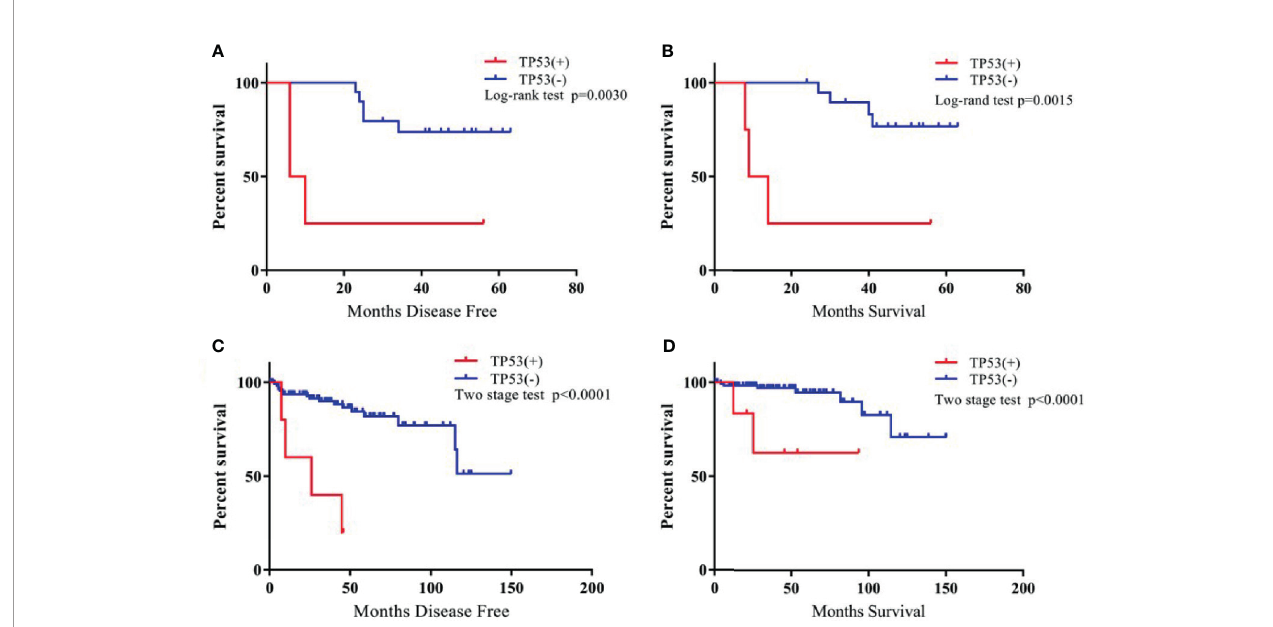
FIGURE 3 | The Kaplan-Meier survival curve of TP53(+) vs. TP53(-) TET patients. (A) : TP53(+) vs . TP53 (-) TET patients of DFS in our cohort; (B) : TP53(+) vs. TP53 (-) TET patients of OS in our cohort; (C) : TP53 (+) vs. TP53 (-) TET patients of DFS in TCGA cohort; (D) : TP53 (+) vs . TP53 (-) TET patients of OS in TCGA cohort.